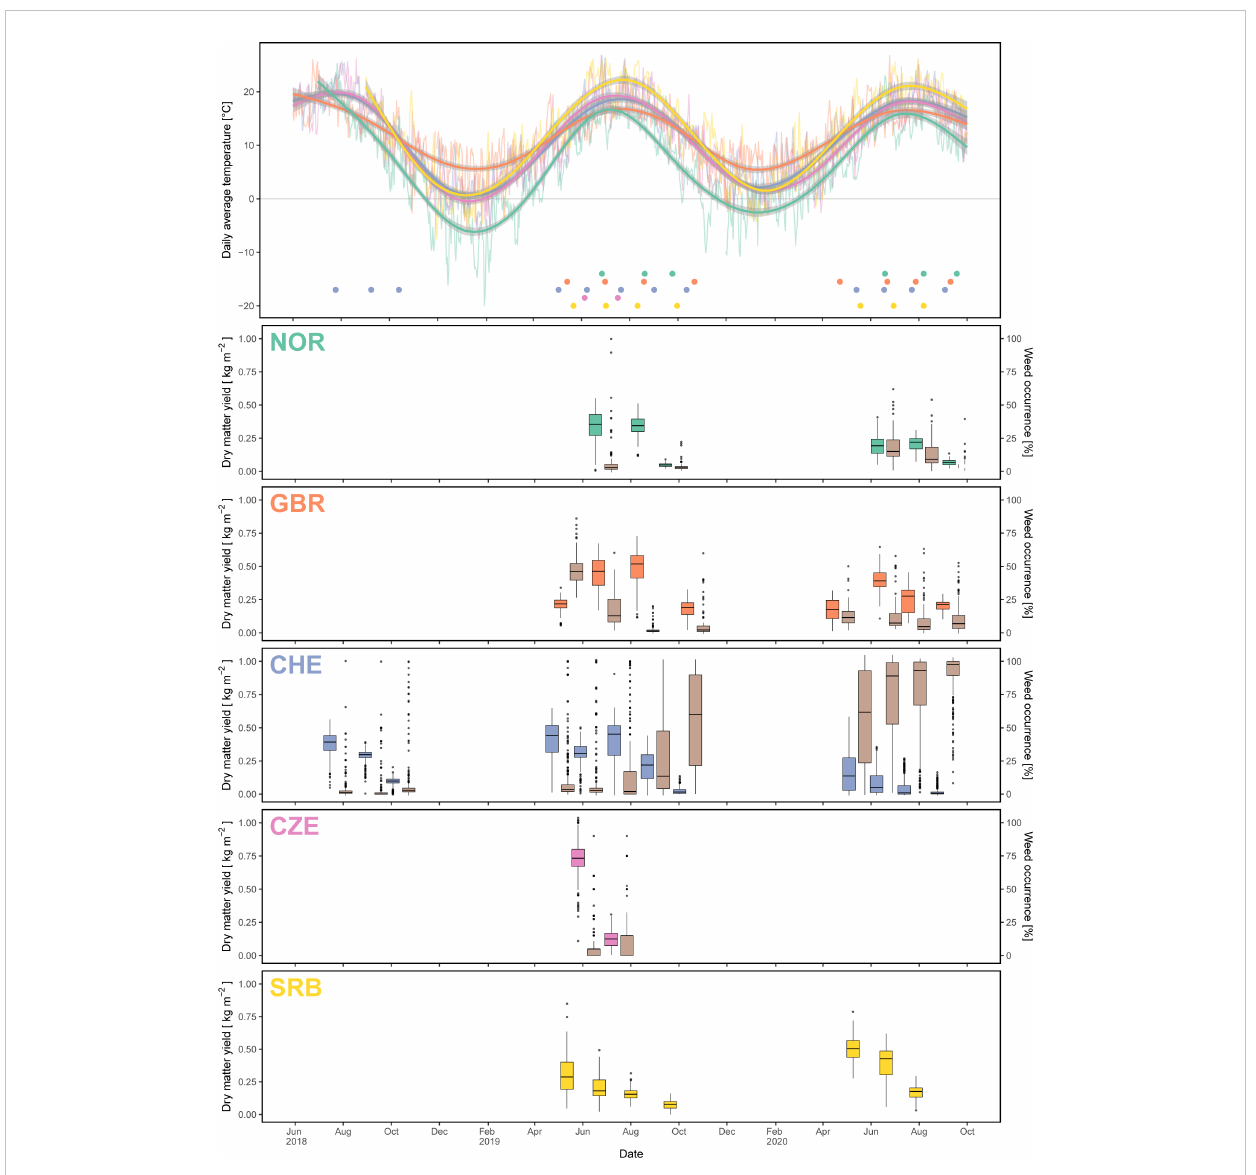
FIGURE 4 Uppermost panel: temperature course during the period of the experiment with thin lines denoting the daily average temperature, thick lines denoting the smoothed temperature and dots showing the cutting dates per location. Subsequent panels: boxplots of dry matter yield (different colour per location) and weed occurrence (brown colour) for each cut and